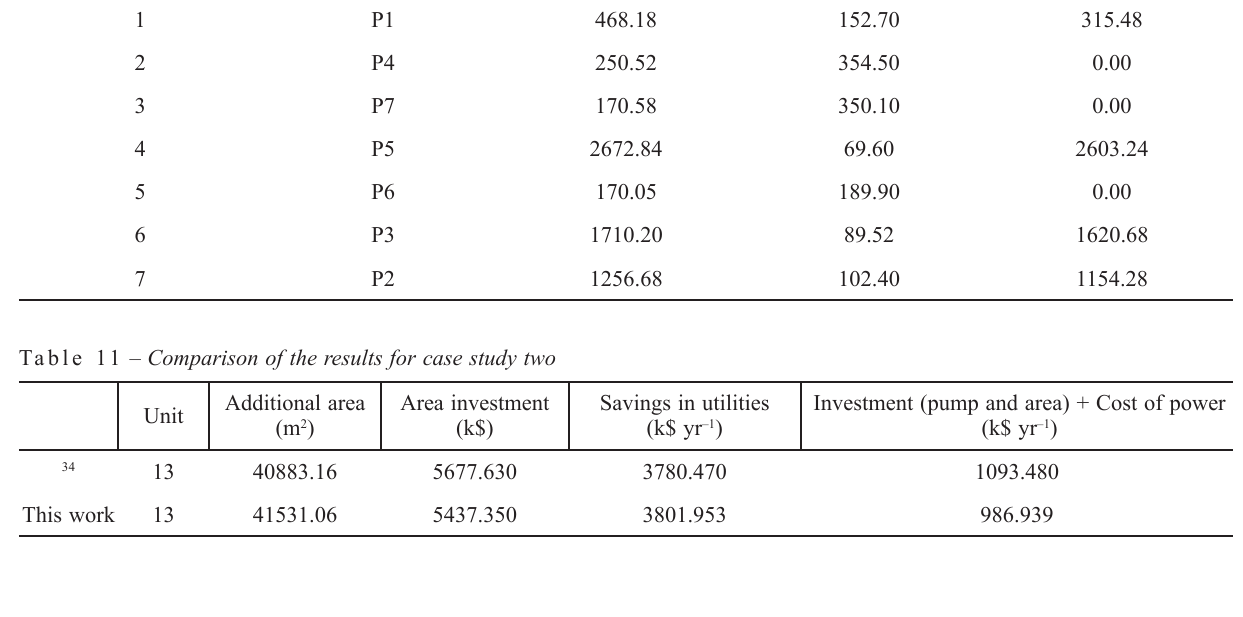
Table 10 – Reassignment of pumps in case study two for the optimal HEN Pump number in initial Pump assignment in new HEN HEN